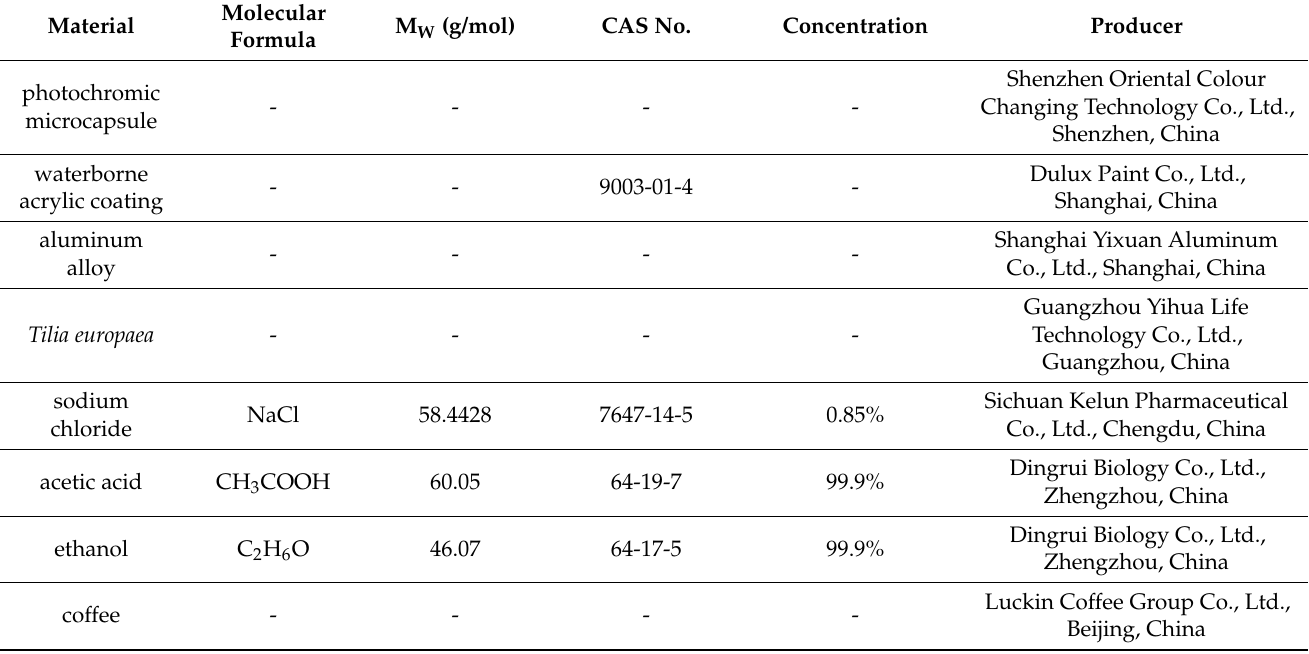
Table 2. List of experimental